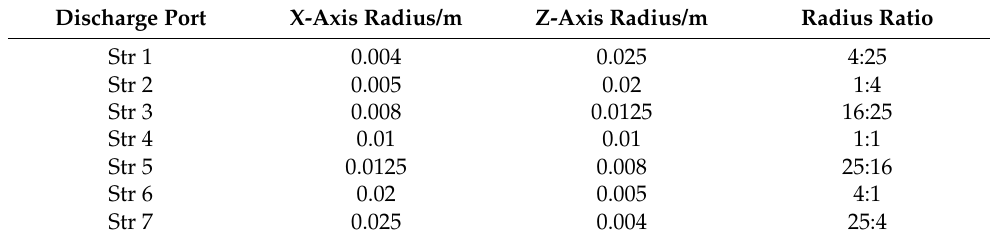
Table 1. Structure parameters of different radius ratios of oval discharge ports.